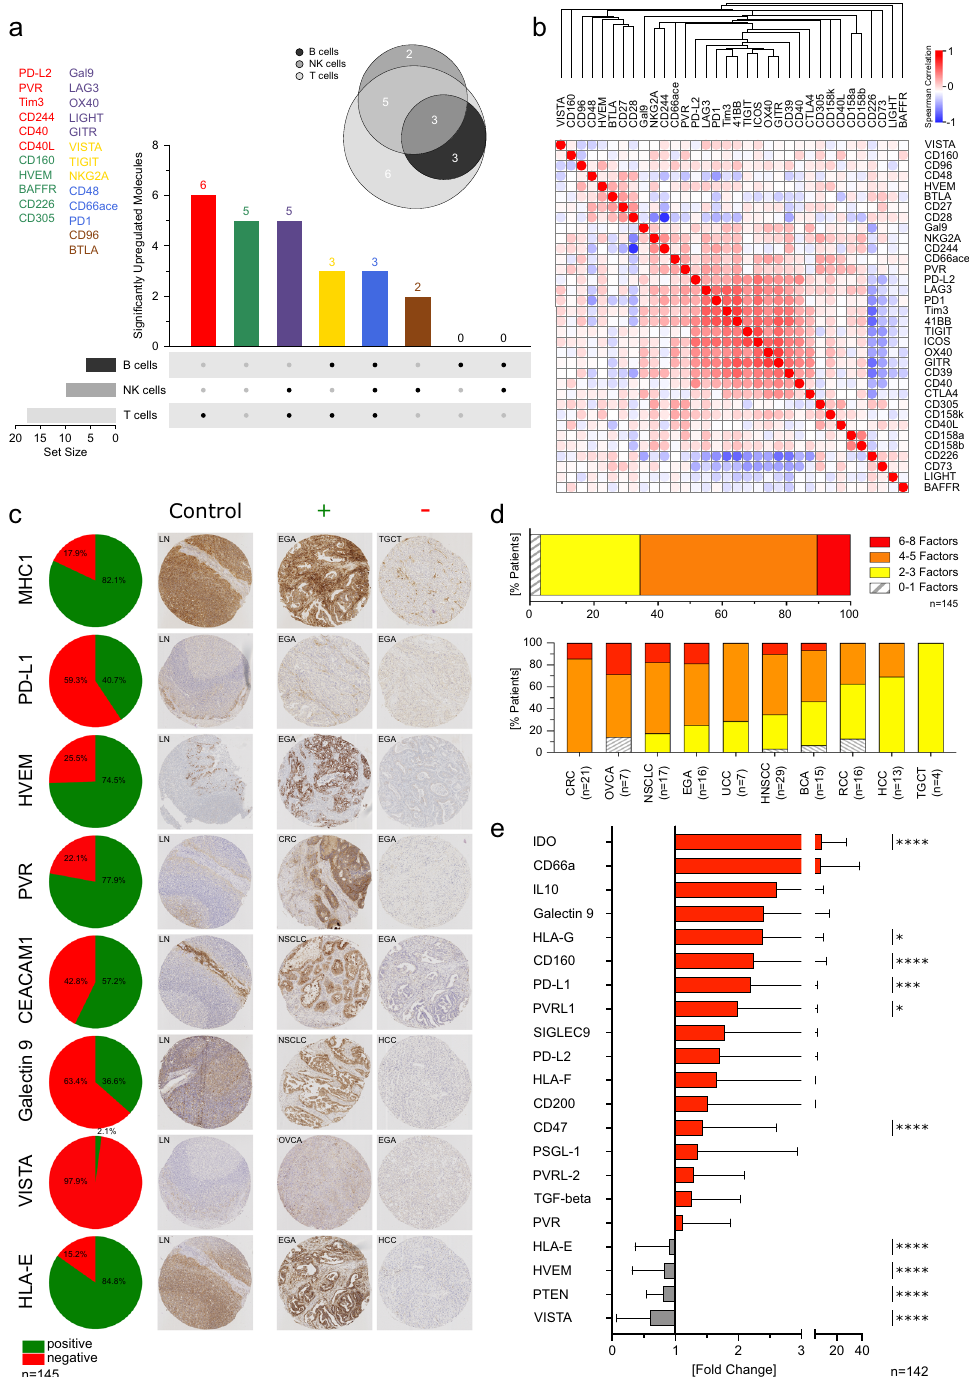
Fig. 3 Co-occurrence of multiple escape factors by tumor cells is cancer dependent. a Illustration showing the expression pattern and co- occurrence of signi fi cantly upregulated molecules on tumor in fi ltrating B, NK and T cells when compared to healthy control PBMCs. b Similarity matrix showing correlations of immune-checkpoint molecule expression on T cells in tumor-in fi ltrating lymphocytes. Expressions were assessed by fl ow cytometry. The heatmap was generated using one minus Spearman rank correlation with single linkage. c Fractions of patients with MHC class I, PD-L1, HVEM, PVR, CECAM1, Galectin9, VISTA and HLA-E positive or negative tumor cells were determined by tissue micro array (TMA) immunohistochemistry. Representative TMA immunohistochemistry staining controls (healthy lymph node) and positive and negative examples of tumor samples are shown. d Percentage of patients expressing multiple immune-escape factors (MHC class I, PD-L1, HVEM, PVR, CECAM1, Galectin9, VISTA, HLA-E) on tumor cells (upper bar chart). Cancer-dependent percentage of patients expressing multiple immune-escape factors on tumor cells (lower bar chart). e RNA expression of immune-escape factors within the tumor microenvironment was determined by NanoString. Relative fold change of RNA expression in tumor compared to normal tissue was determined for each patient individually. Mean fold change ± SD is indicated. Signi fi cant differences calculated with two-tailed, unpaired Mann – Whitney test ( a ) and two- tailed Wilcoxon matched-pairs signed rank test ( e ) are indicated by asterisks. * p ≤ 0.05, ** p ≤ 0.01, *** p ≤ 0.001, **** p ≤